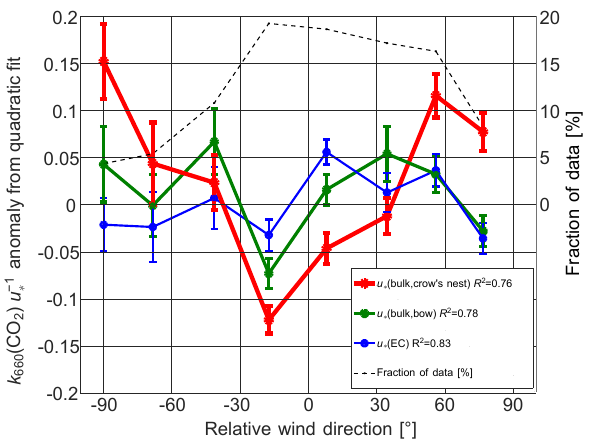
Figure 7. Average relative deviations ( δk = k meas /k fit (u ∗ ) − 1) from linear fits to k 660 (u ∗ ) as a function of the relative wind di- rection. The relative anomalies are averaged into relative wind di- rection sectors (25 ◦ bins). The error bars indicate the standard error of the mean value of each sector. The red and green lines show the anomalies for direct EC k 660 and bulk u ∗ derived from the AWS (crow’s nest) and the bow mast anemometer, respectively. The blue line shows the anomalies for the ratio of direct EC k 660 and direct EC u ∗ . The coefficients of determination (R 2 ) of the polynomial fits are provided in the legend. The black dashed line indicates the fraction of data observed in each wind direction sector.